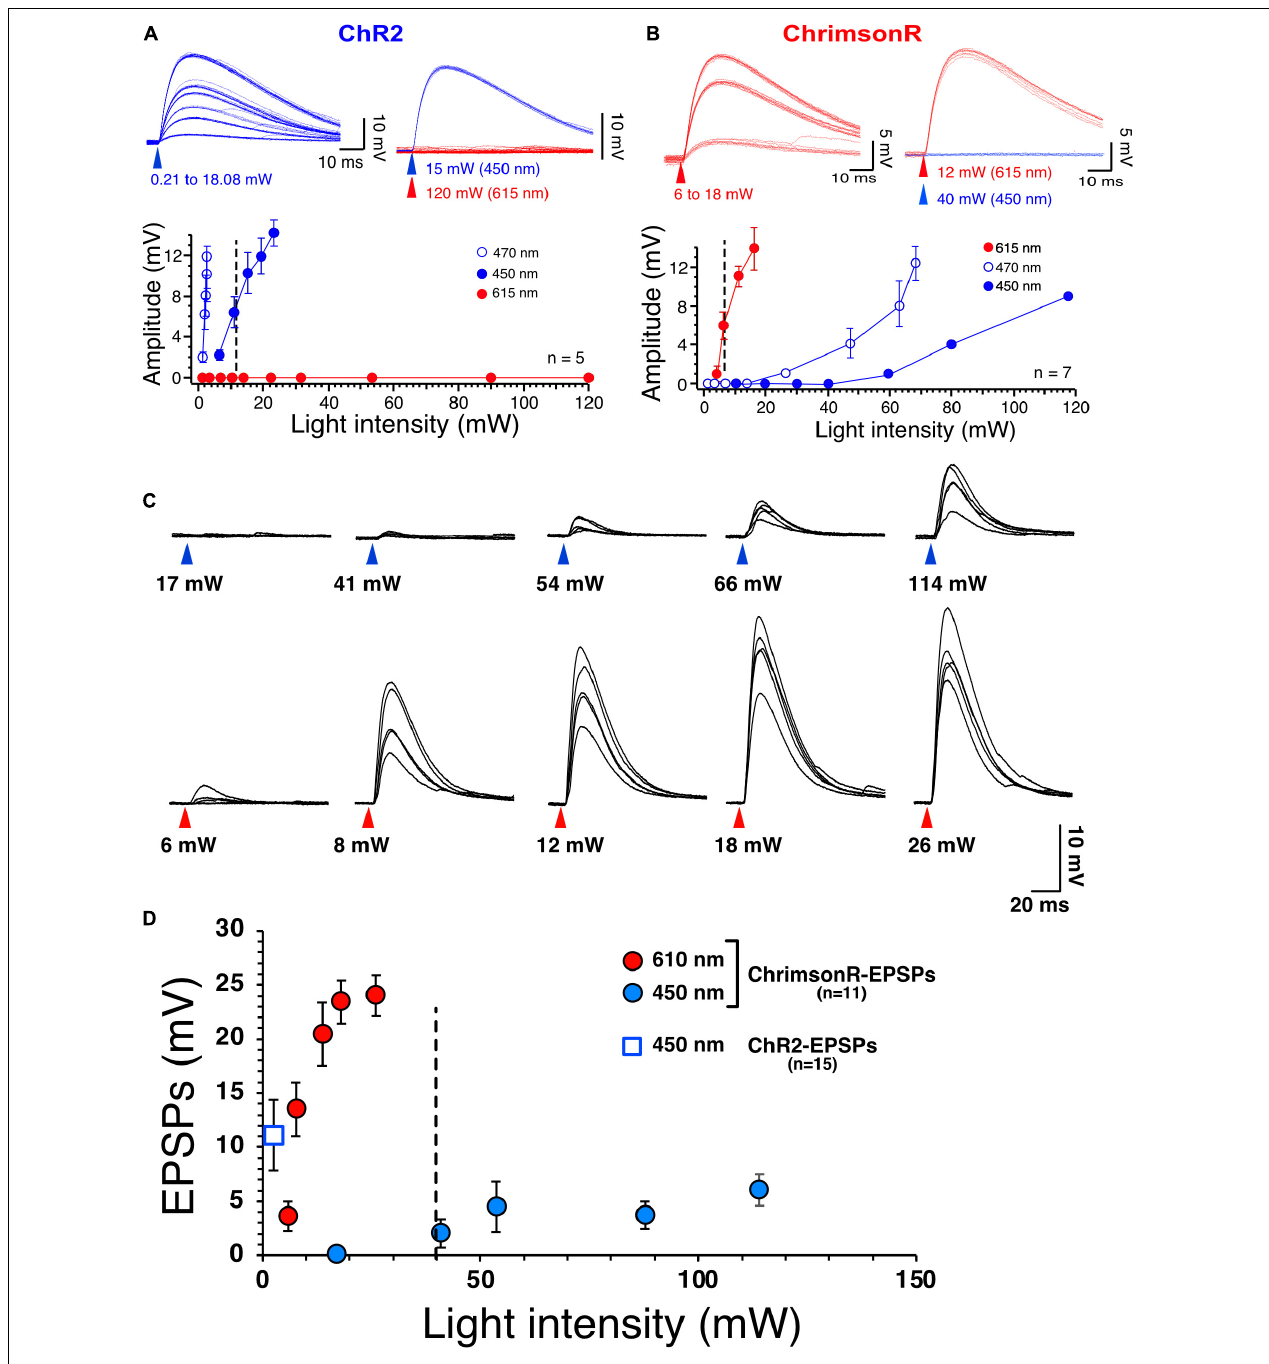
FIGURE 1 | Selective stimulation of ChR2 and ChrimsonR. (A) Voltage responses of ChR2 expressed in NAc MSNs to increasing intensities of 450 nm blue light (blue traces) and 615 nm red light (red traces, top right panel). Bottom panel shows graph of ChR2-mediated voltage responses as a function of light intensity at 450 nm (solid blue circles, n = 5), 470 nm (open blue circles, n = 5) and 615 nm light intensity (solid red circles, n = 5). Note the lack of sensitivity of ChR2 to red light. (B) Voltage responses of ChrimsonR expressed in NAc MSNs to increasing intensities of 615 nm (red traces, n = 7) and 450 nm blue light (blue traces, top right panel, n = 7). Bottom panel shows graph of ChrimsonR-mediated voltage responses as a function of light intensity at 450 nm (solid blue circles, n = 7), 470 nm (open blue circles) and 615 nm light intensity (solid red circles). Average values in graphs are expressed as mean ± standard error (SEM). (C) Representative EPSPs following injection of AAV-ChrimsonR in PFCx in response to increase intensity to 450 nm (blue triangles) and 610 nm (red triangles) light. Note that blue light evokes EPSPs at intensity higher than 40 mW. (D) Graph showing ChrimsonR-mediated EPSP amplitude as a function of increasing light (450 – solid blue squares and 610 nm – solid red squares) intensities. Open blue square shows the average amplitude of ChR2-mediated EPSPs as a function of low 450 nm light intensity (0.78 mW).